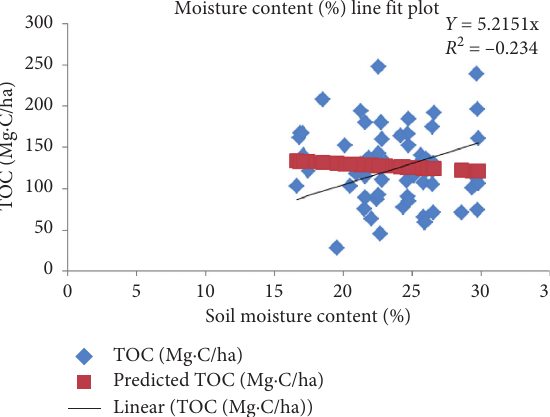
Figure 5: Relationship between soil moisture and soil carbon stocks.